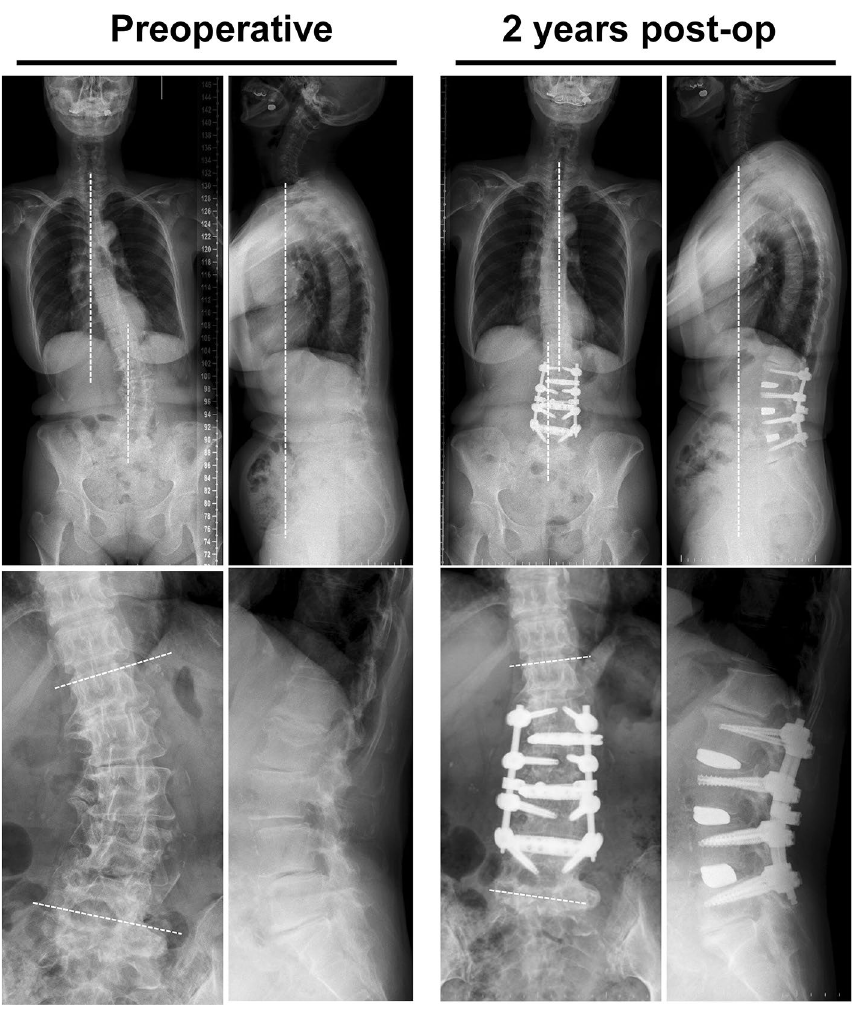
Figure 3. A 68-year-old female with gait disturbance mainly due to frontal trunk tilt. Preoperative radiological parameters showed poor global alignment with Cobb angle 30.6°, coronal decompensation 59.9 mm, C7 SVA 116 mm, and PI-LL 18.4°. These parameters improved to 1.4°, 6.1 mm, 62.5 mm, and 15.9°, respectively, at 2 years after surgery.